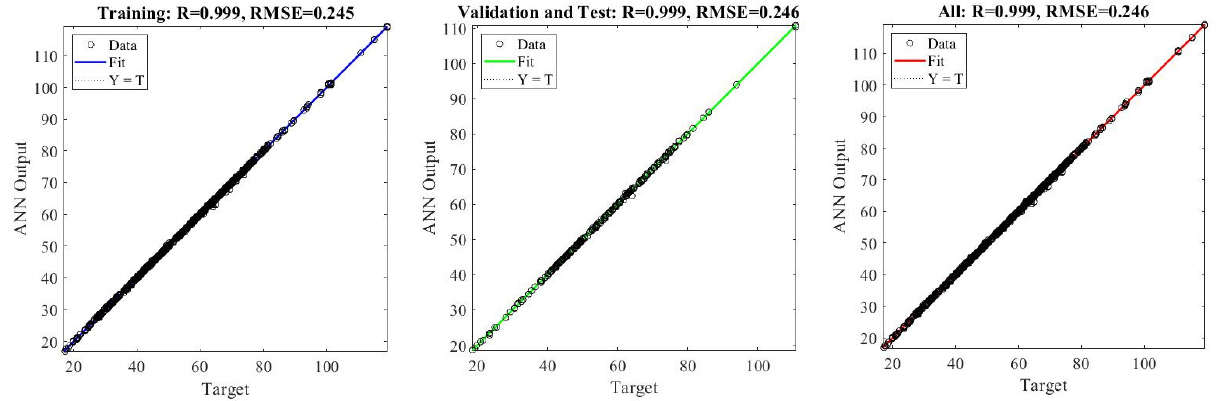
Fermentation 2021 , 7 , 71 9 of 15 sm for training, testing and all targets together. Figure 3. Comparing of simulation and prediction of Figure 3. Comparing of simulation and prediction of sm hydrogen for training, testing and all targets together. hydrogen